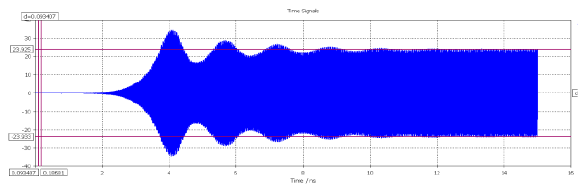
Fig. 6. Simulated output signal for BWO with 0.7 A hollow electron beam with wall thickness of